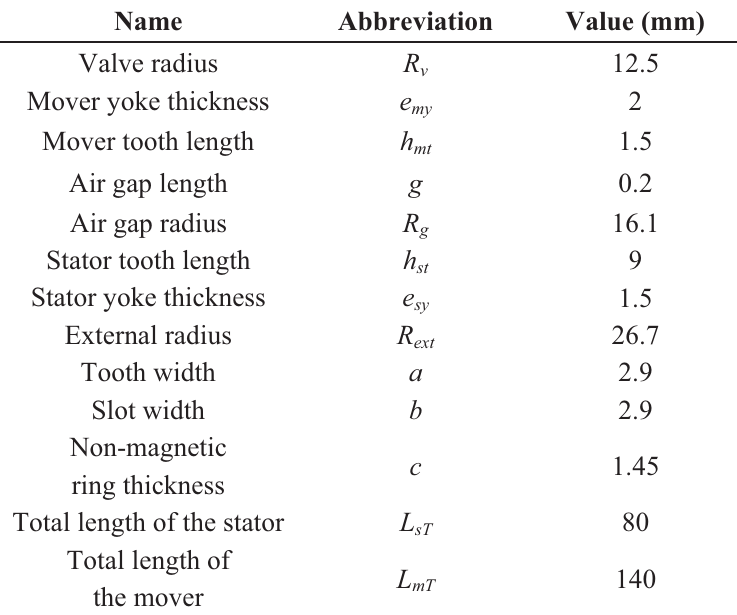
Table 1. Prototype